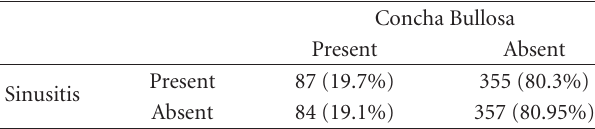
Table 6: Relationship of concha bullosa and